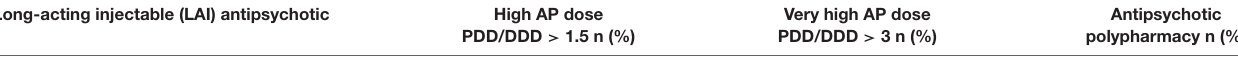
TABLE 6 | Use of first or second-generation LAI antipsychotics in patients receiving high/very high-dose antipsychotics and antipsychotic polypharmacy. Long-acting injectable (LAI) antipsychotic High AP dose PDD/DDD > 1.5 n